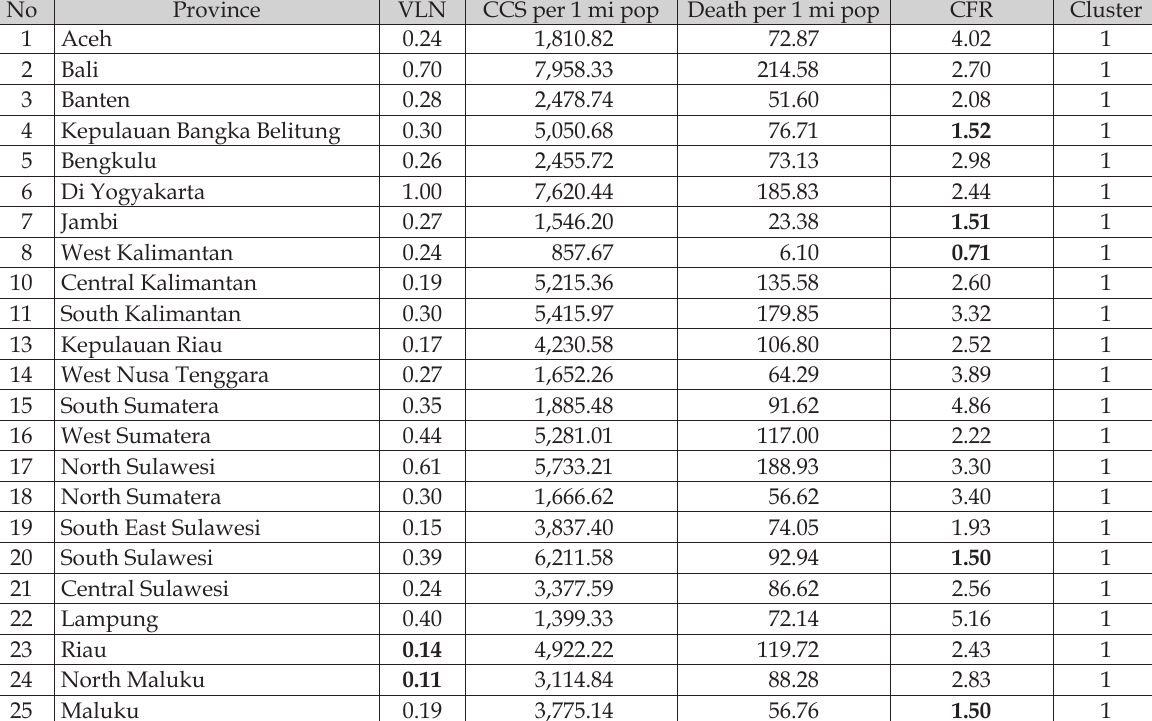
Fig. 7. The cluster of COVID-19 based on VLN, cumulative cases, death cases, and CFR in every province. VLN – vulnerability; CFR – case fatality rate. Source: own elaboration. Table 2. Cluster membership of COVID-19 in every